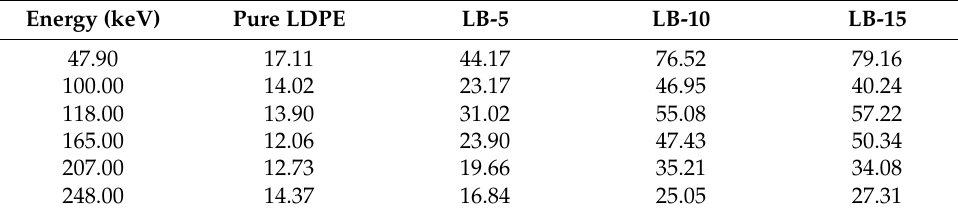
Table 8. The RPE values in % for the samples prepared in this